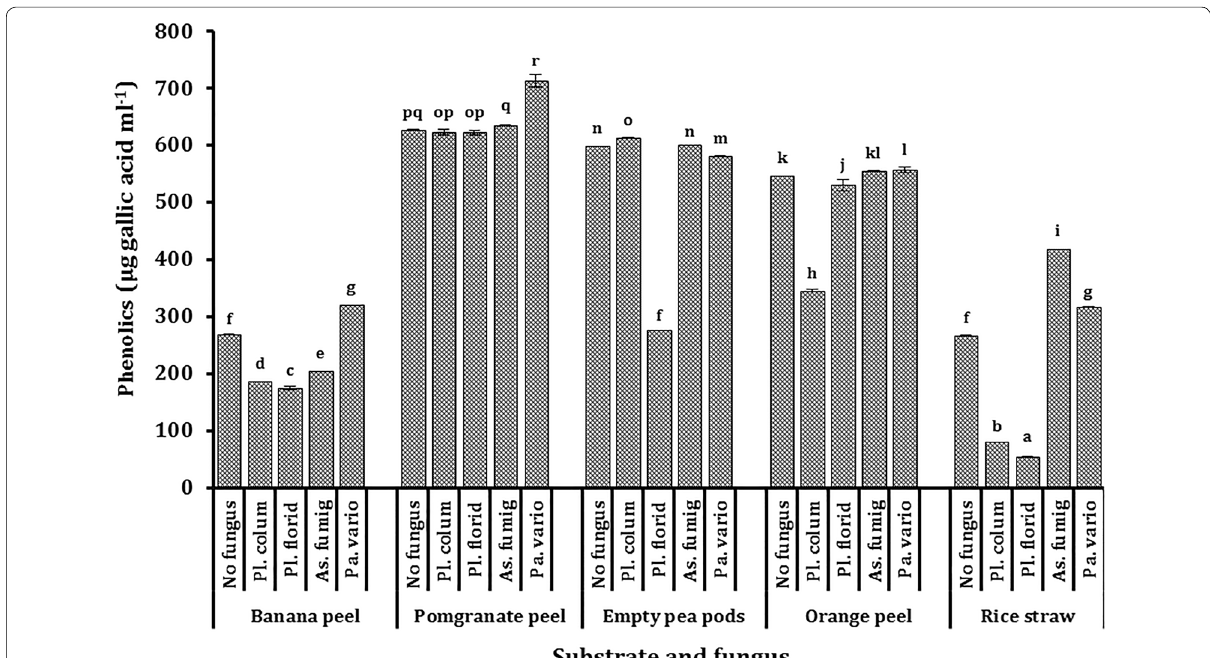
Fig. 1 Phenolic content of an SSFS employing two basidiomycete fungi: P. columbinus and P. floridanus and two ascomycetes: A. fumigatus and P. variotii on peels of banana, pomegranate and orange, empty pods of pea and rice straw. Each column represents the mean of three replicates Columns with common letters are not significantly different at P < 0.05